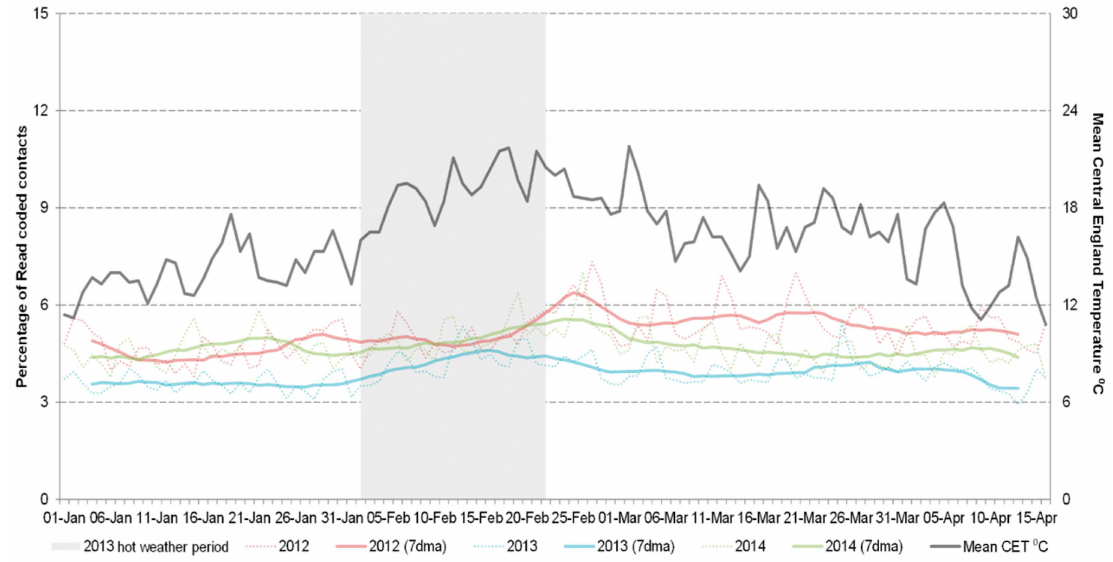
Figure 2. Daily GPOOH consultations for rash 15–64 years (including seven day moving average) 2012–2014.